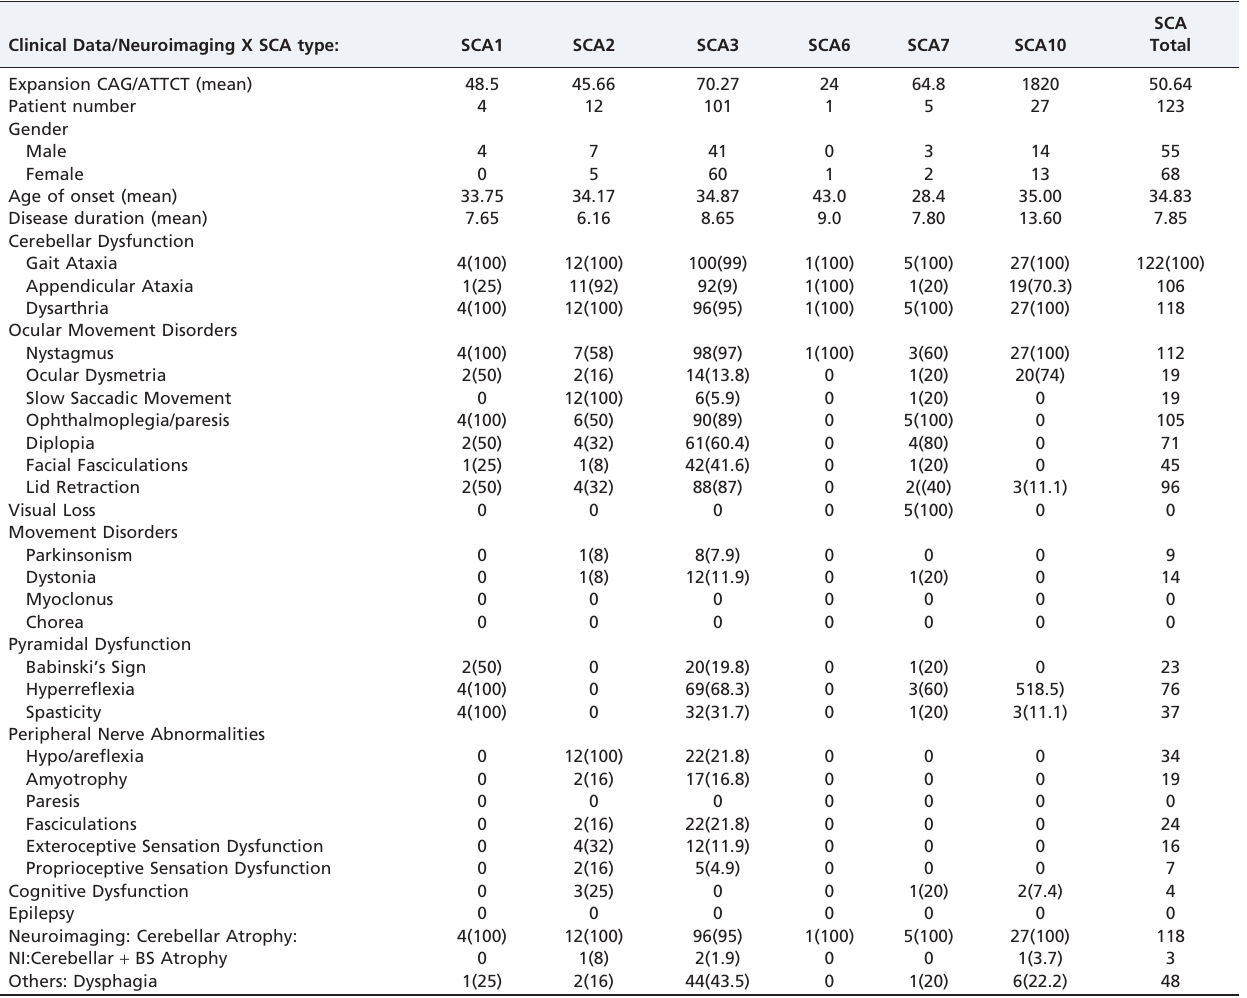
SCA= Spinocerebellar Ataxia; NI= Neuroimaging; BS= Brainstem; SCA Total= All SCAs, without SCA10.